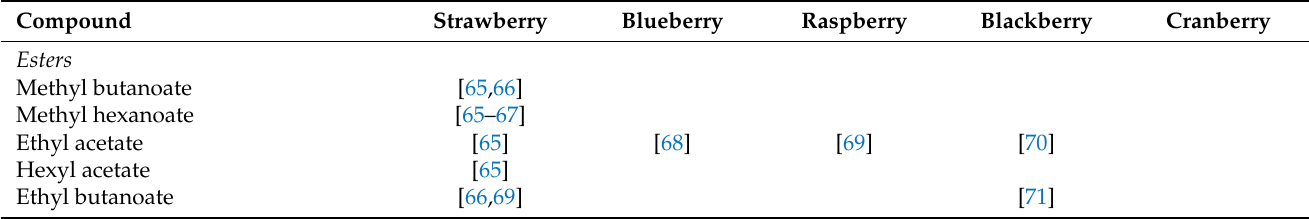
Table 1. The major volatile compounds in